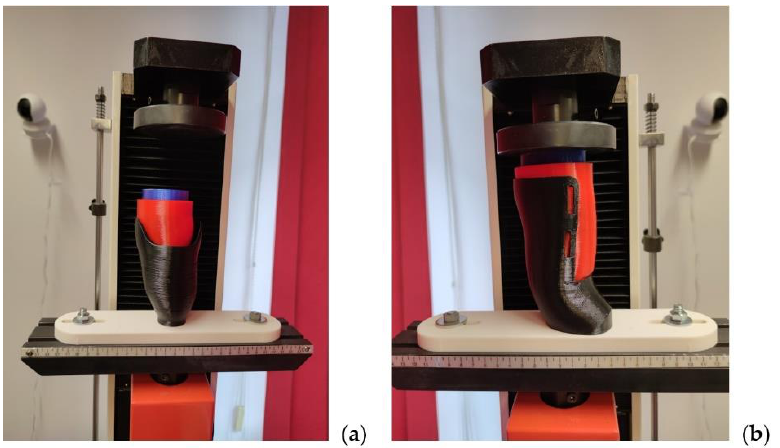
Figure 7. Two-material stump phantom used in the strength testing of the VAC ( a ) and VEL ( b ) sockets.